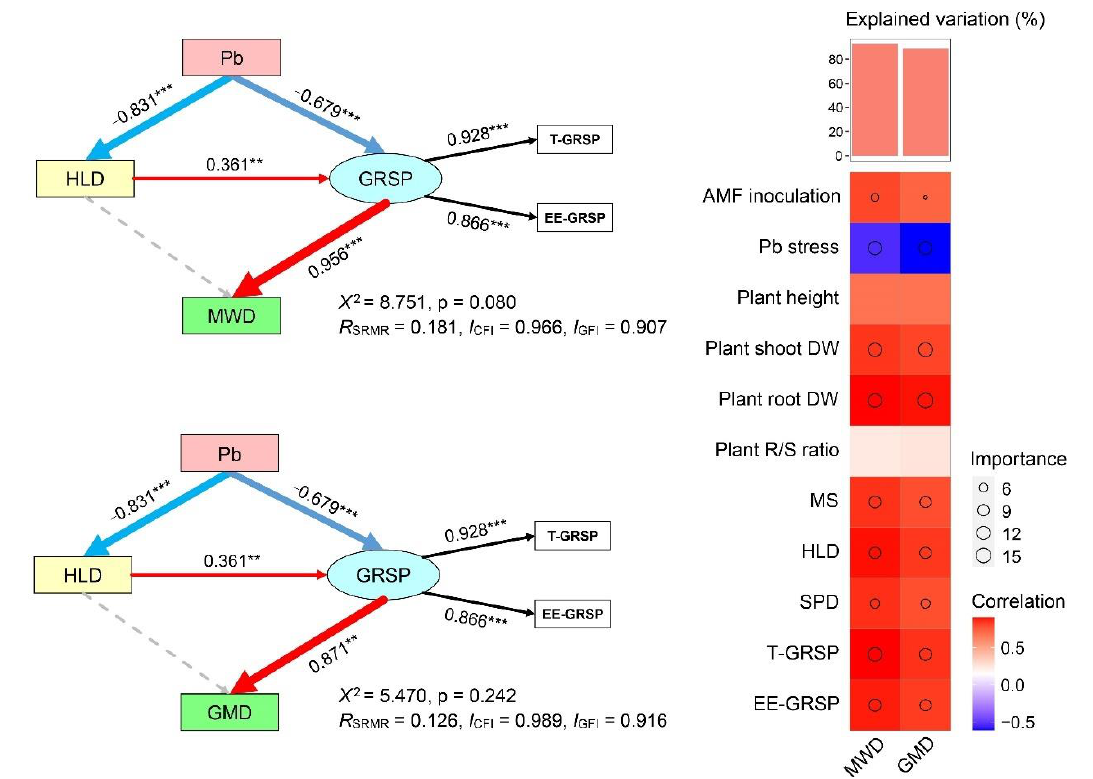
Figure 8. Structural equation model (SEM) illustrating the effects of Pb on soil-aggregate stability, and random forest variable importance score for all analyzed variables. Continuous and dashed arrows represent the significant and non-significant relationships, respectively. Adjacent numbers that are labeled in the same direction as the arrows represent path coefficients, and the width of the arrows are in proportion to the degree of path coefficients. Red and blue arrows indicate positive and negative relationships, respectively. Significance levels are denoted by ** p < 0.01 and *** p < 0.001.